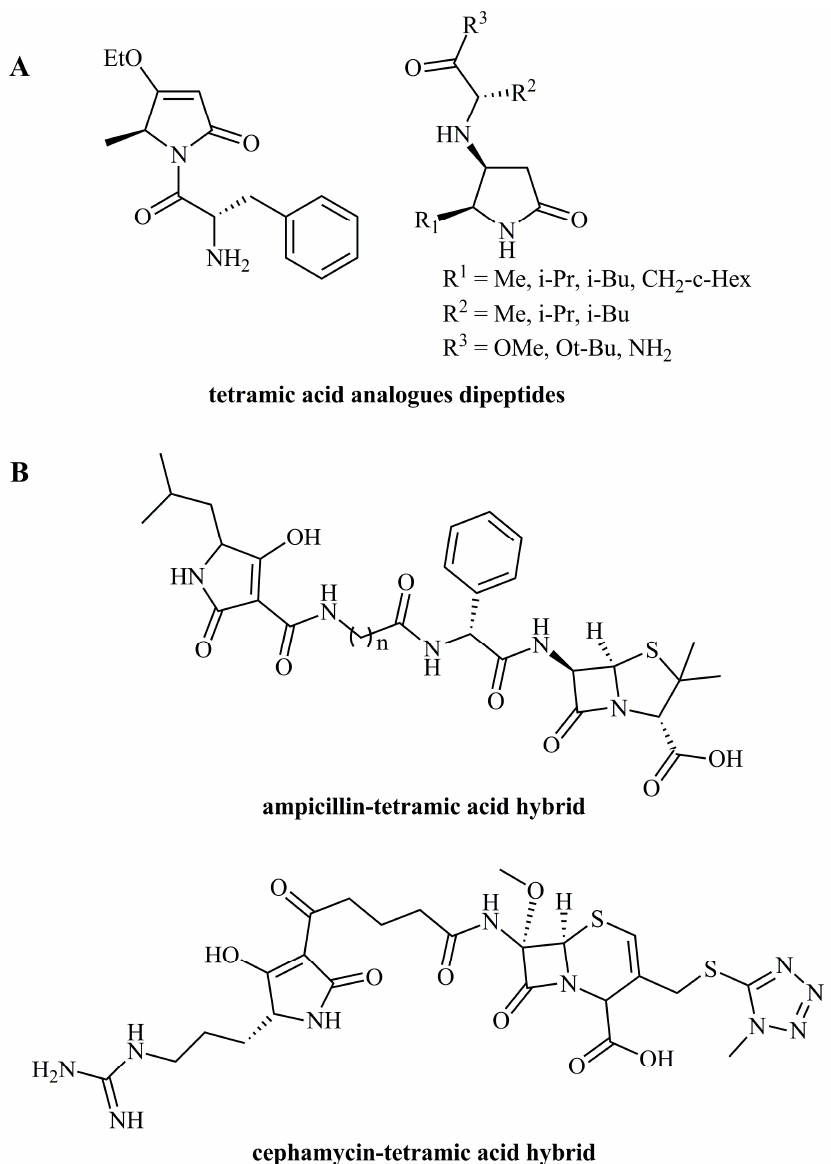
Figure 3. Representative examples of tetramate and tetramic acid analogues dipeptides ( A ) and β -lactam-tetramic acid hybrids ( B ).